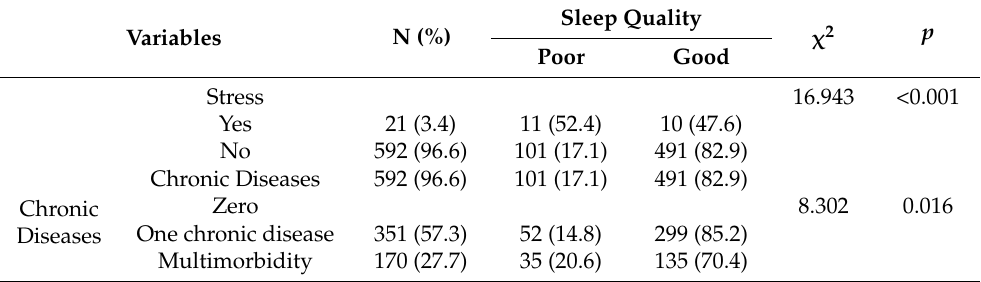
Table 3 displayed the association between chronic disease, mental health, and sleep